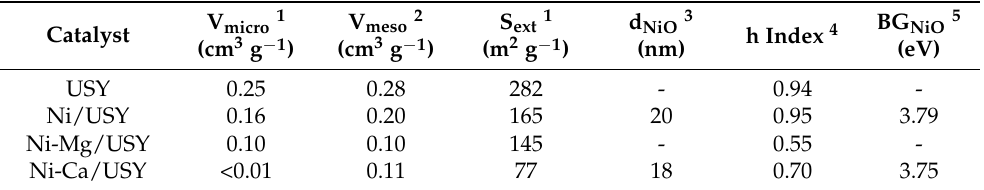
Table 2. Main properties obtained for the Ni-AE/USY catalysts, Ni/USY reference sample and USY support after